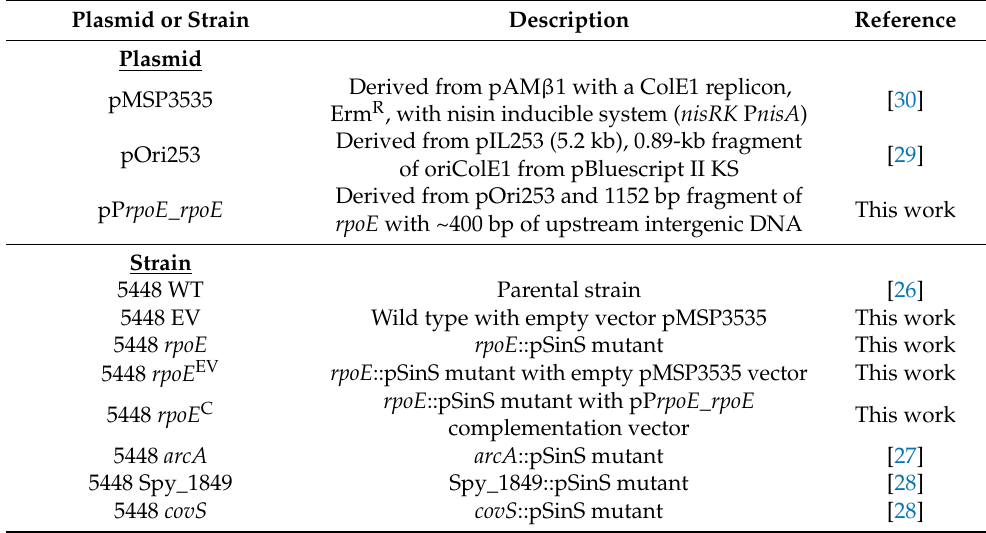
[30] [29] This work